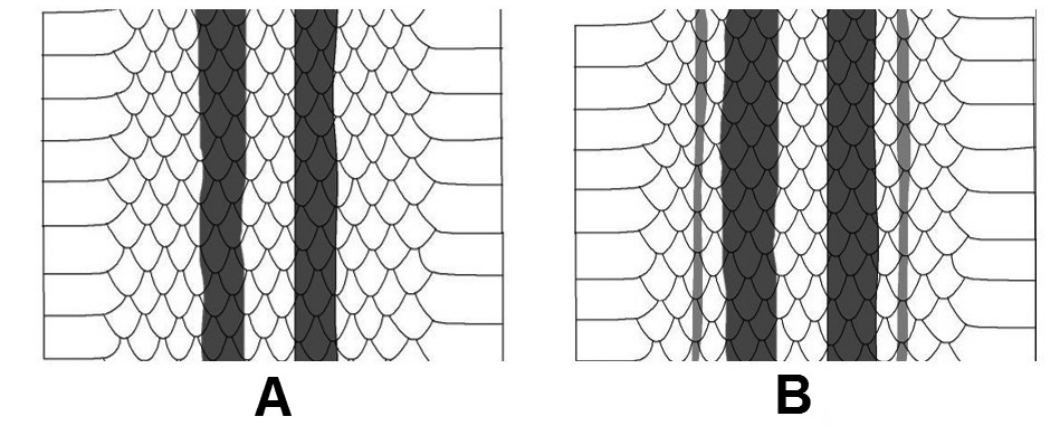
Fig. 17. A . Lateral line absent. B . Lateral line always present and well